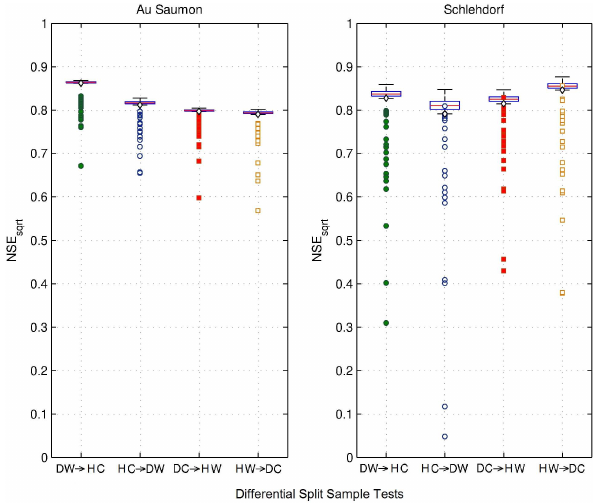
Fig. 13. Individual and multimodel DSST validation performance. Boxplots depict the range of the multimodel combinations, dia- monds represent the twenty-model ensemble, and the circles and squares, the individual models, for the Au Saumon and Schlehdorf